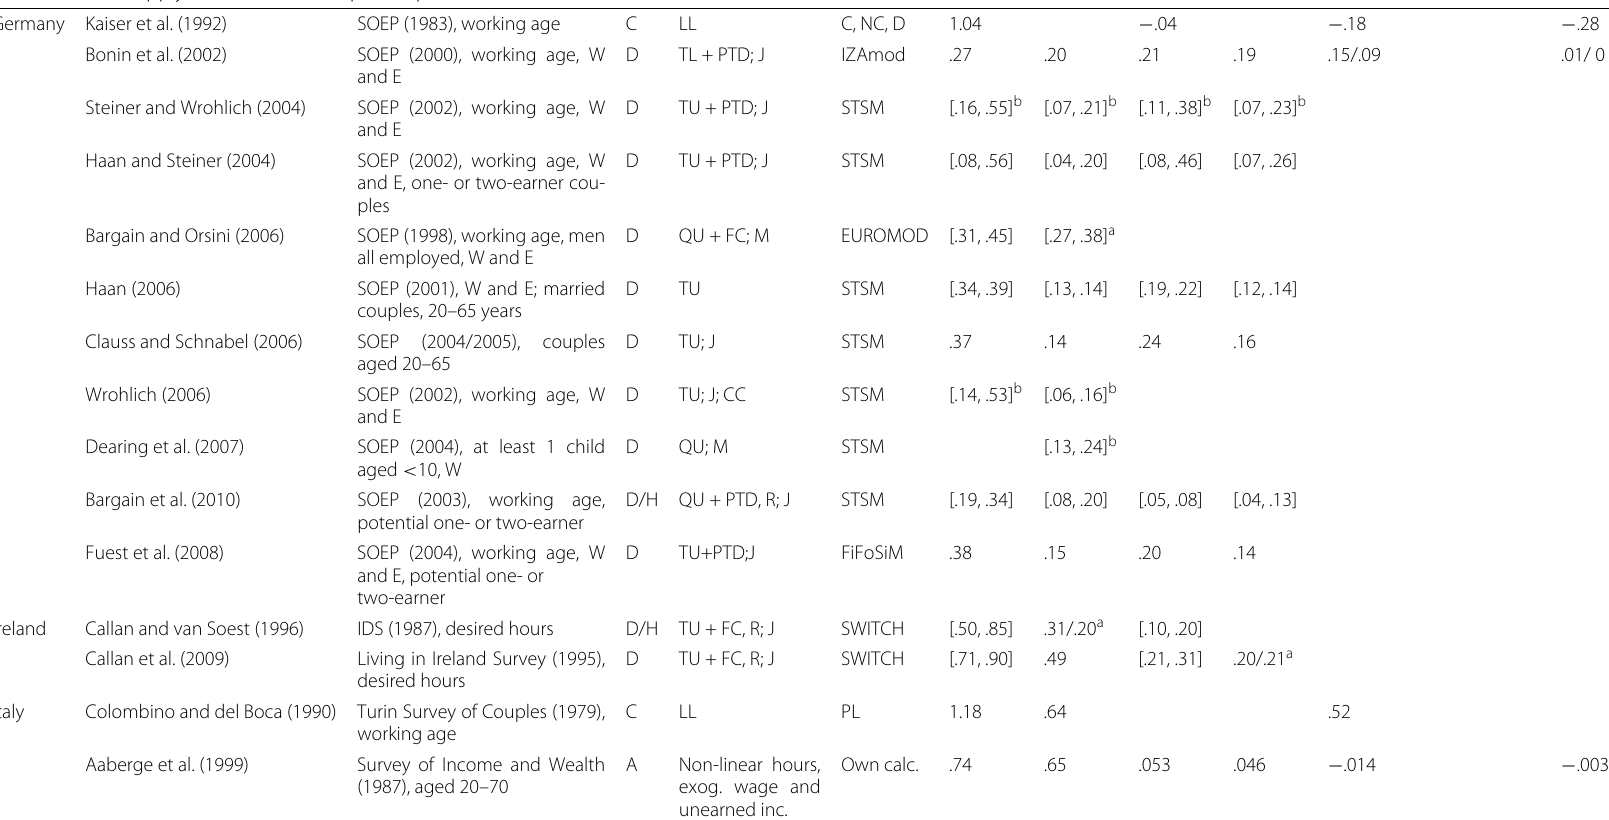
Table 1 Labor supply elasticities in Europe: couples (Continued) Germany Kaiser et al. (1992) SOEP (1983), working